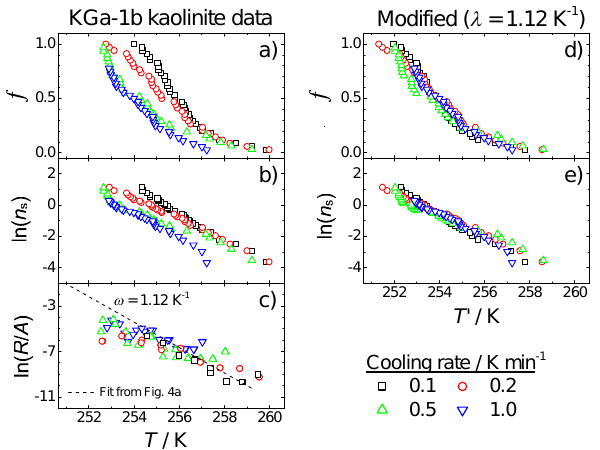
Figure 6. The freezing of droplets containing K-feldspar for a range of cooling rates. Layout as in Fig. 5. Brackets beside the cool- ing rates indicate the number of experiments performed and sub- sequently combined. Linear fits to derived ln( R/A ) values for runs at 0.2 and 2.0Kmin − 1 are shown as solid lines in (c) resulting in ω = 0.85 and 0.9 K − 1 , respectively. Modified n s (T 0 ) data were minimised in order to determine a value of λ that best describes the cooling-rate dependence, resulting in λ = 3.4K − 1 . In this example ω 6= λ suggesting that K-feldspar is a diverse INP species and be- haves as a multiple-component system. The dashed line in (e) is a fit to K-feldspar experimental data taken from Atkinson et al. (2013). Temperature uncertainty is as in Fig. 4, and uncertainty in n s and R/A (not shown) is estimated as ±